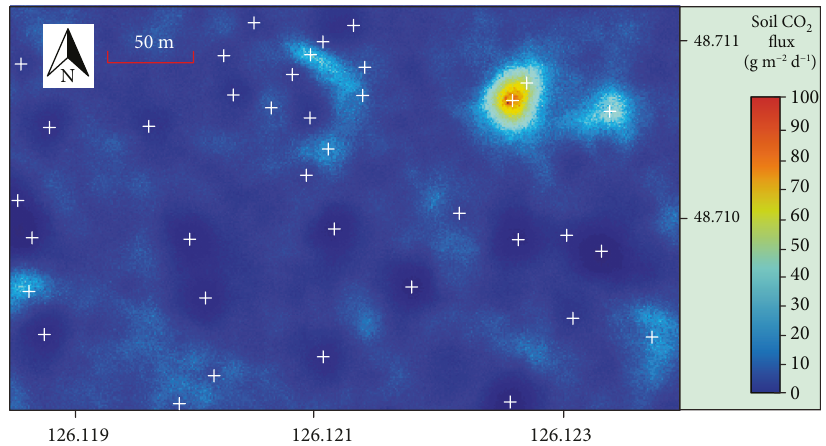
fl ux map in the SE slope of the Laoheishan volcanic cone obtained by sequential Gaussian Figure 4: CO 2